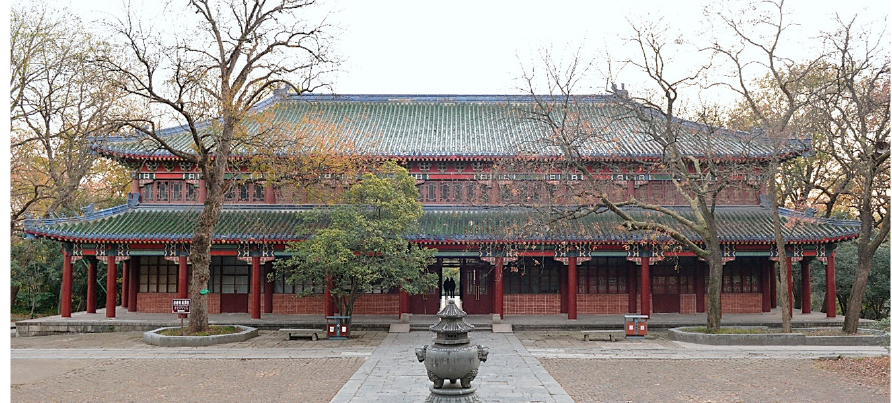
Figure 8. The picture of the Songfengge Building.